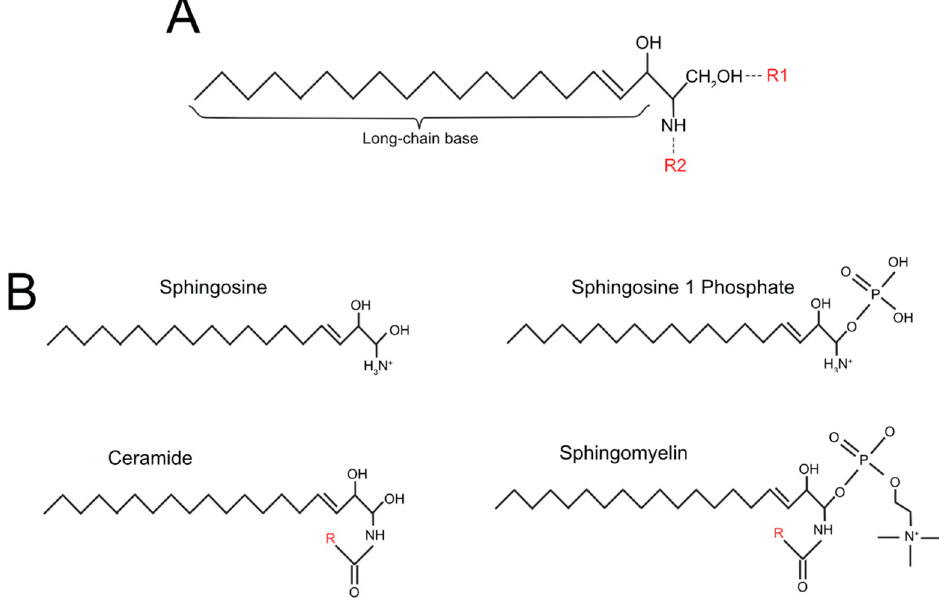
Figure 1. Basic structure of sphingolipids ( A ) and of the four more studied sphingolipids ( B ). Table 1. Structures of